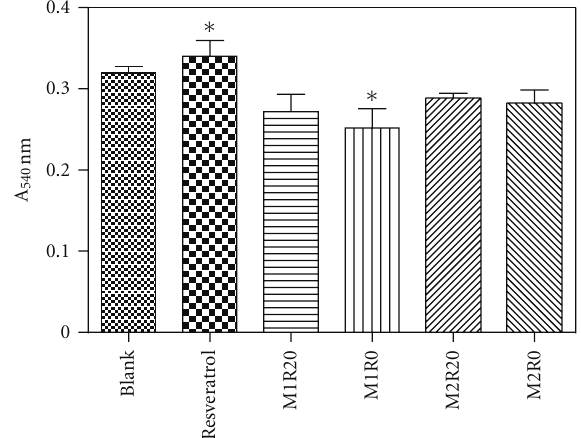
Figure 10: Absorbance values resulting from the released hemo- globin in erythrocyte hemolysis assay for blank, pure resveratrol, and PHBV/PCL microparticles. The asterisk indicates statistically significant di ff erence ( P = 0 .